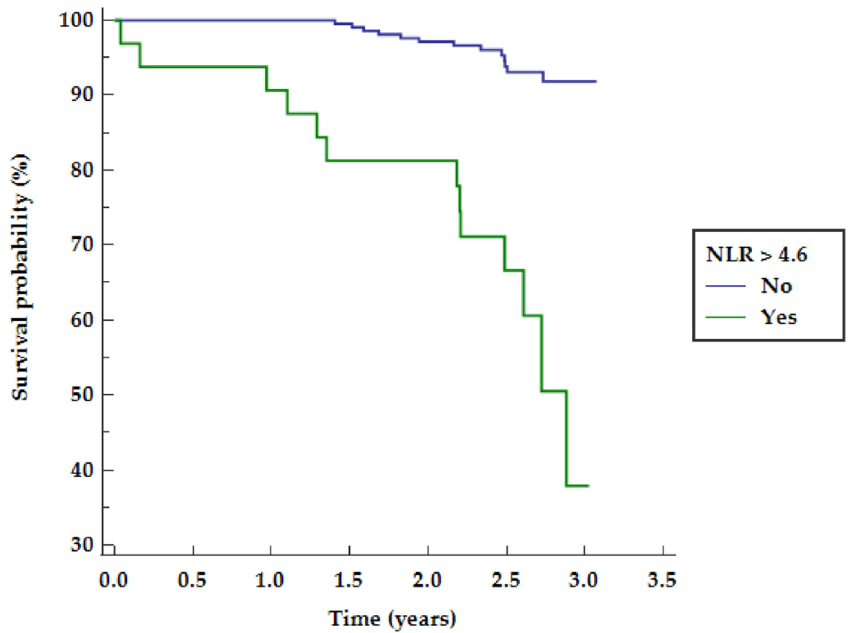
Figure 1. NLR probability of mid-term survival. NLR—neutrophil to lymphocyte ratio. Postoperative ejection fraction (HR 0.9, 0.87–0.95 95%CI, p < 0.0001) and laboratory